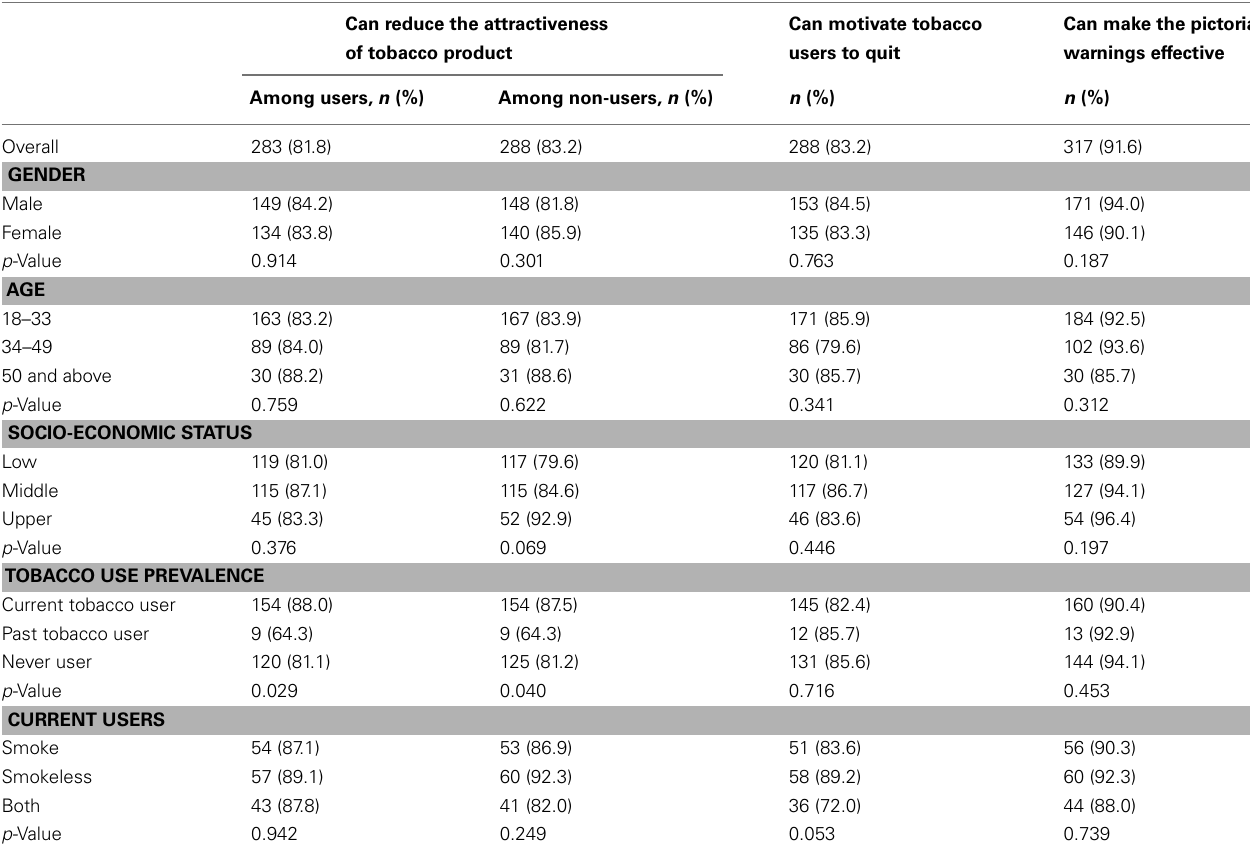
Table 3 | Perceptions about plain packaging on its effectiveness, by demographic profile and tobacco use status of the